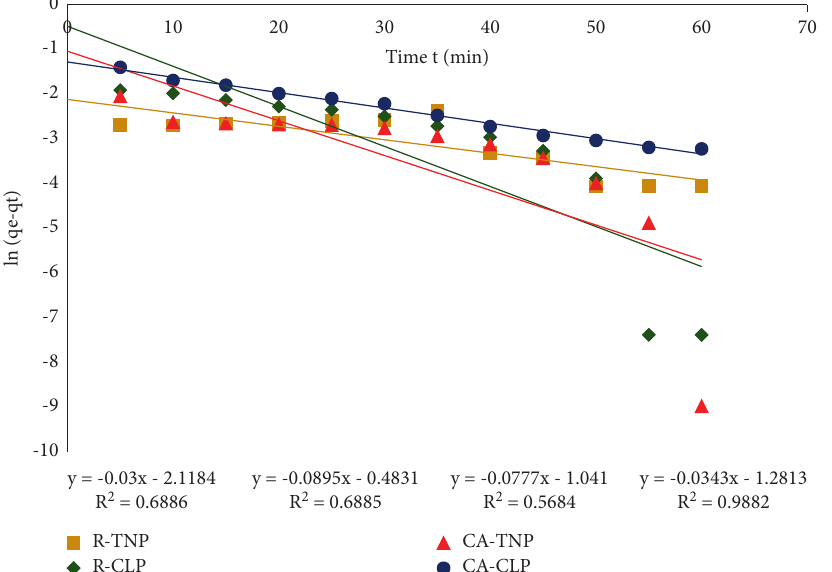
Figure 15: Comparison of pseudo-first-order kinetics for the adsorption of BGD. Time period � 5 to 60min, adsorbent dose � 0.5g, temperature � 30 ° C, agitation speed � 100rpm, initial pH � 5, final pH: R-TNP � 5, R-CLP � 4.5, CA-TNP � 4.0, and CA-CLP � 4.0, and initial volume of the solution V �